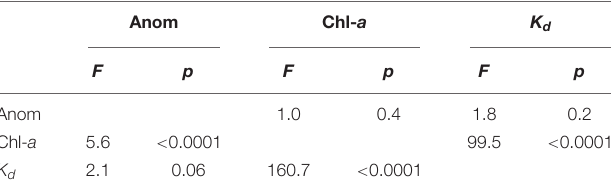
Columns indicate the response variable for each test, and rows indicate the predictor variables. F-value (F) and p-value (p) reported for each combination of